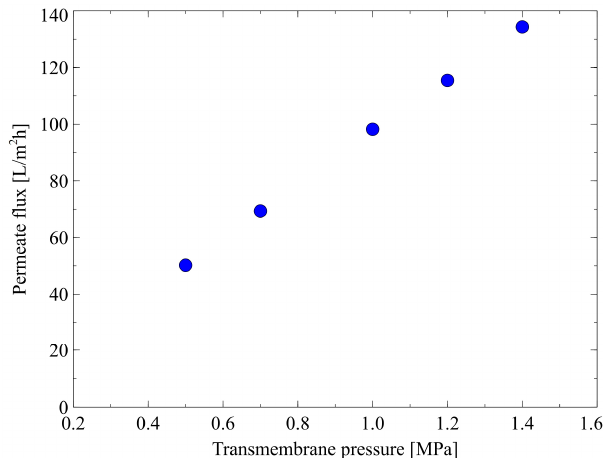
Figure 5. Water flux as a function of transmembrane pressure. T = 298 K.